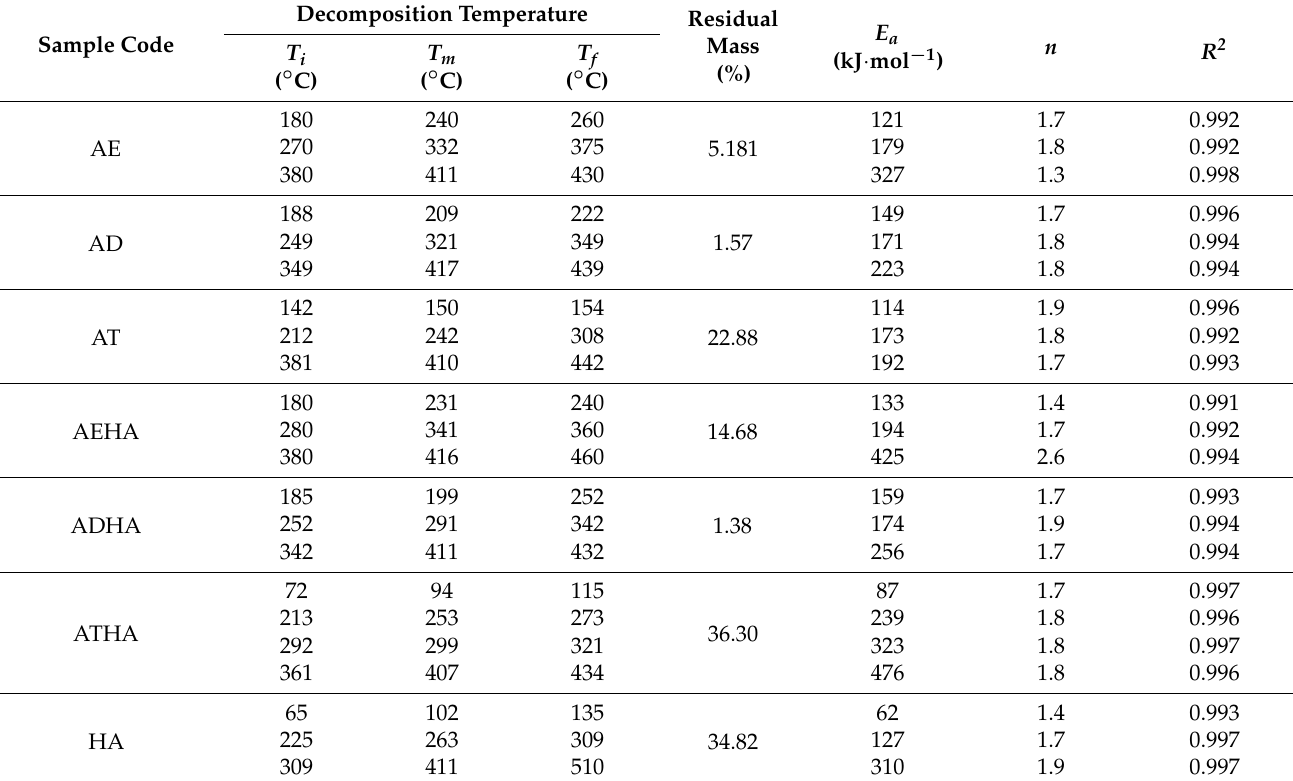
Table 3. Thermogravimetric characteristics of precursor/hybrid